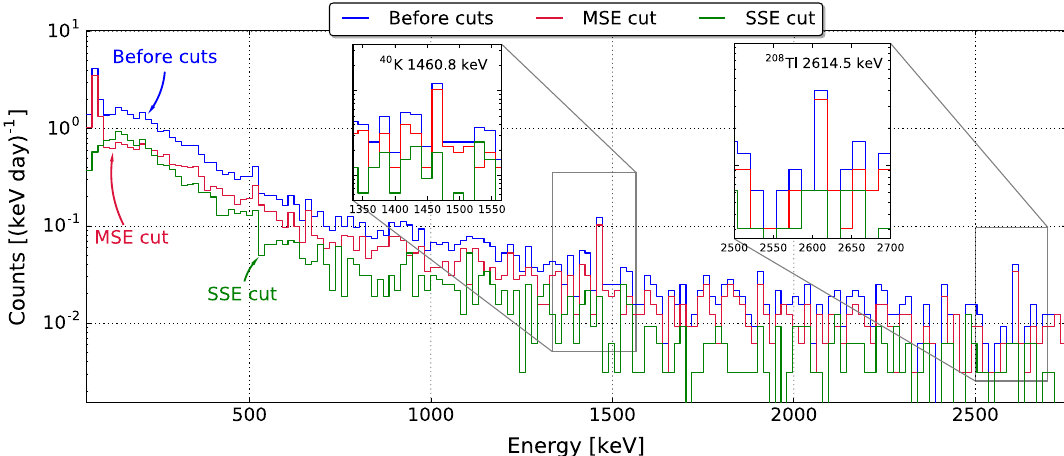
Fig. 9 The effect of the PSA cut on the background spectrum. The only visible peaks in the spectrum, i.e. the 1460.8 keV peak from 40 K and 2614.5 keV from 208 Tl are shown in